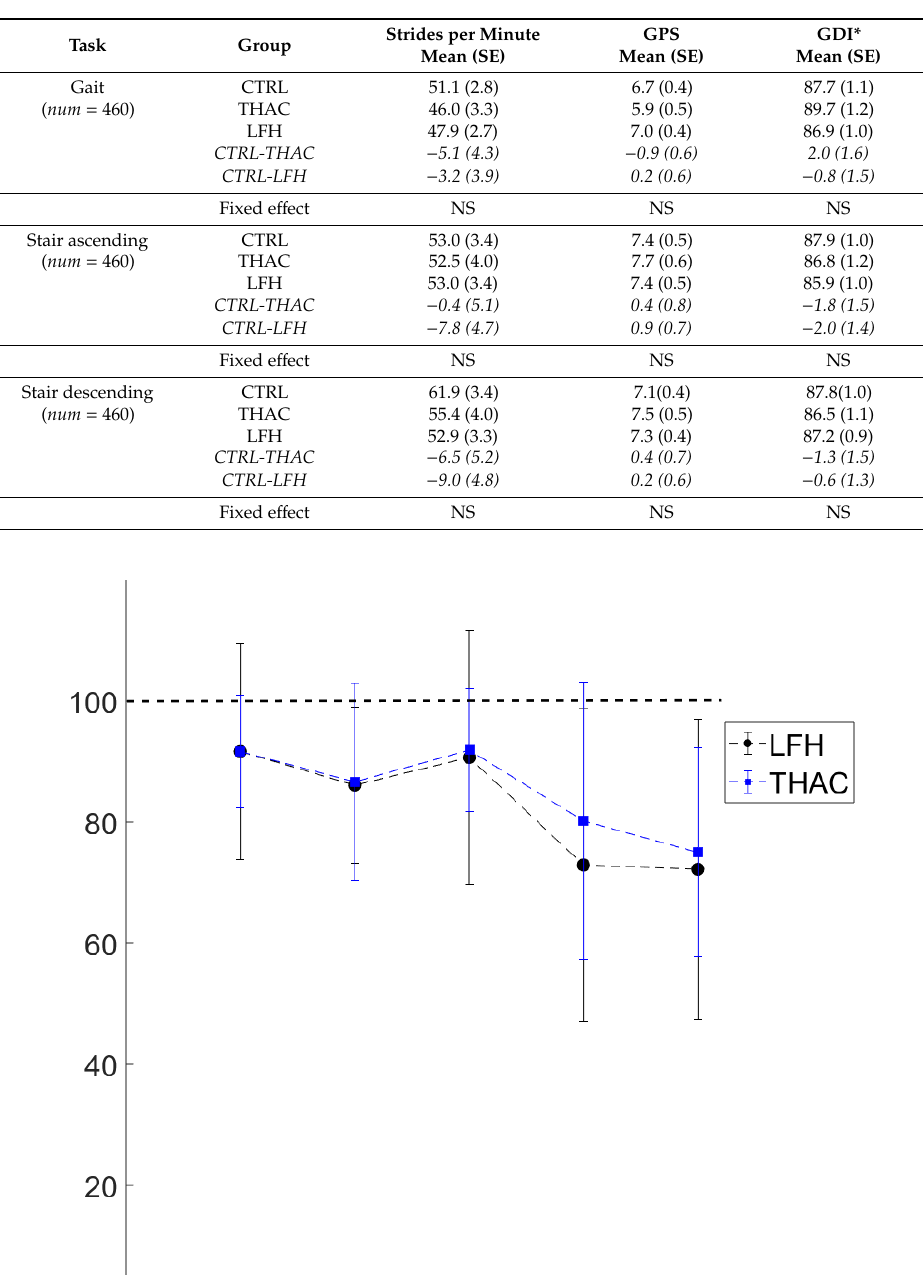
Table 2. Group estimated means and standard error (SE) in stride frequency, Gait Profile Score (GPS) and Gait Deviation Index (GDI*) for healthy controls (CTRL), the conventional total hip replacement group (THAC), and the large femoral head (LFH) design group. “ Num” = number of observations (i.e., 23 participants x 5 trials x 4 cycles). The estimated group di ff erences written in cursive text . “NS” = Non-significant.